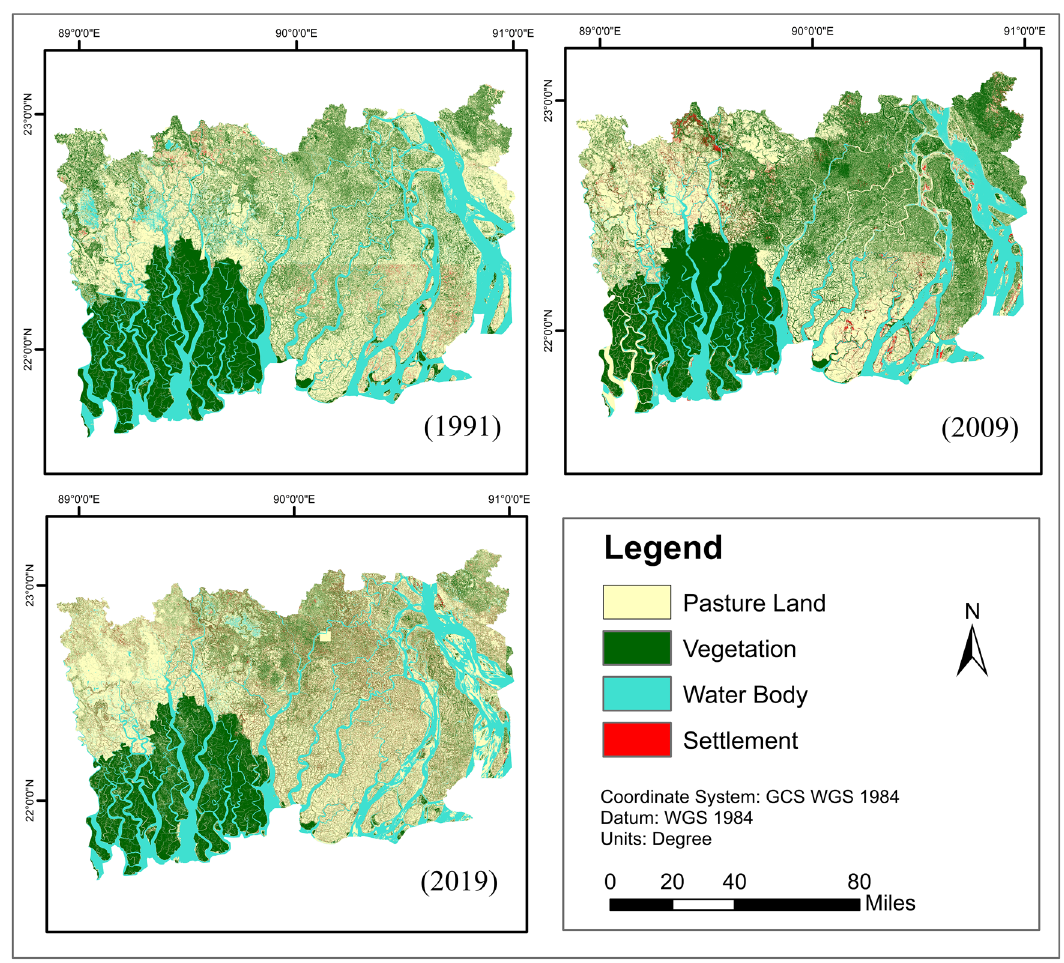
Fig. 10 Changes in land use from classified images of 1991, 2009, 2019